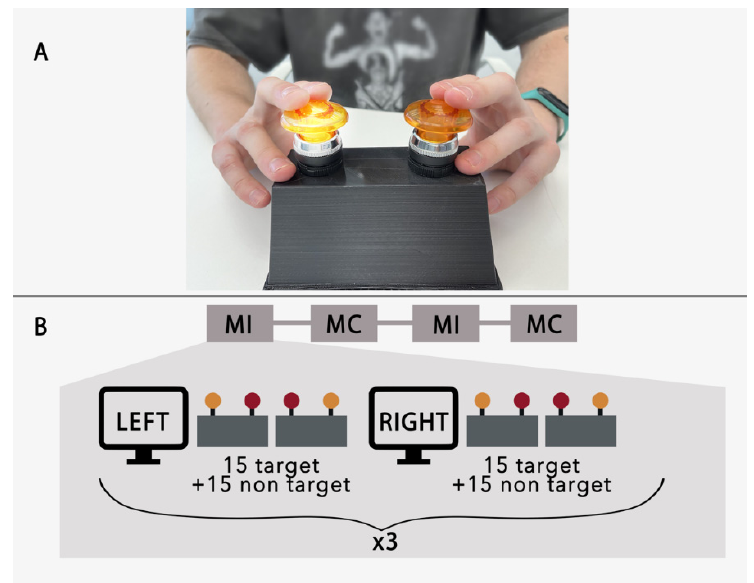
Figure 1. ( A ) Two press buttons with LEDs for button illumination. Participants held their hands on the buttons and responded to button highlights, when instructed, by imagining pressing the button. ( B ) Experimental sequence. “MI” and “MC” correspond to motor imagery and mental counting